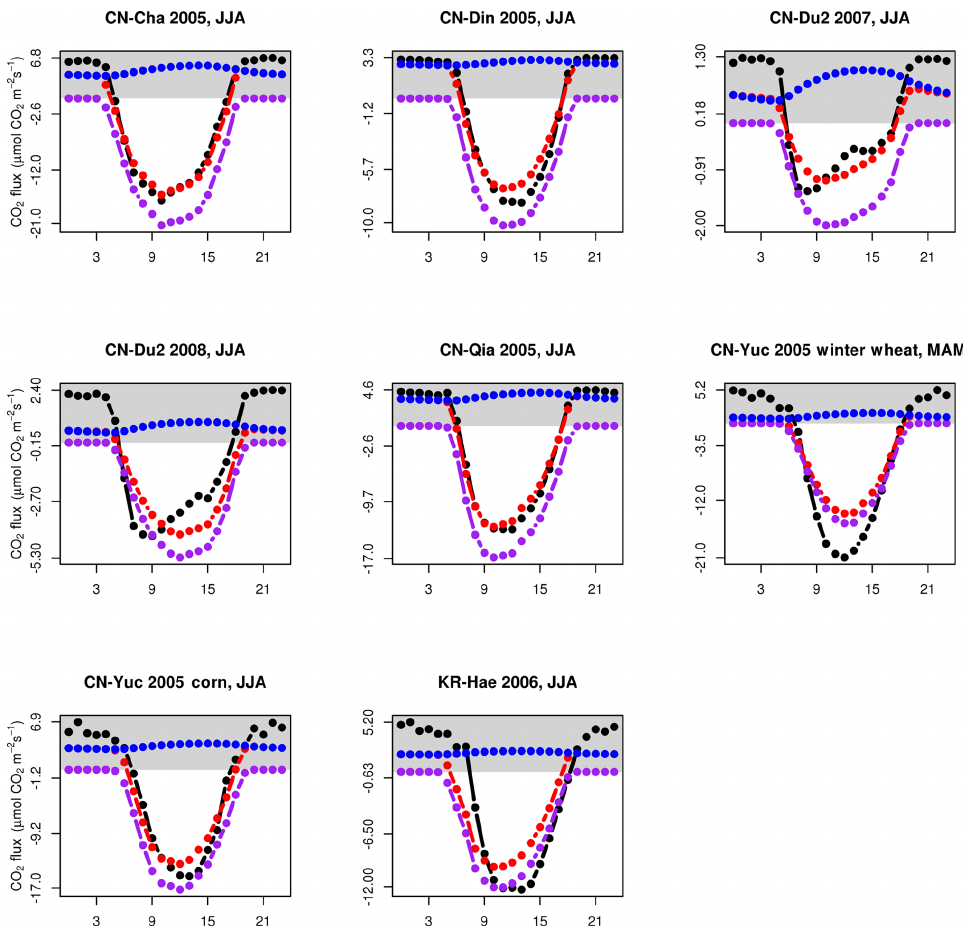
Figure 5. Peak growing-season diurnal mean measured NEE (black) along with modeled NEE (red), modeled GPP (purple), and modeled R eco (blue) vs. local hour of day (UTC + 8h). Grey shaded region represents region of positive fluxes (release to